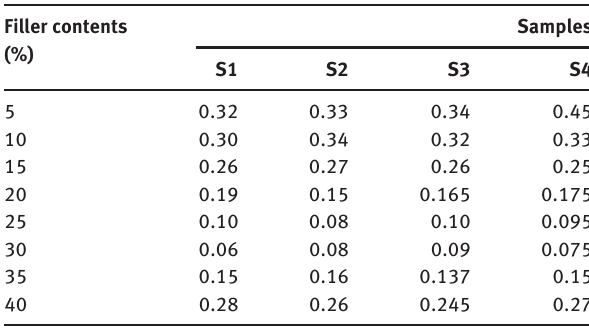
Table 4: Friction coefficients of the NaOH-treated CNS filler epoxy composites with various filler contents.